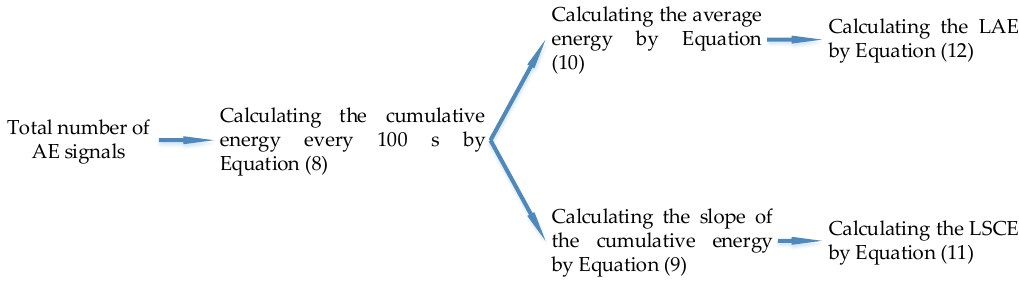
Figure 3. The flow chart to calculate the average energy and the slope of cumulative energy.